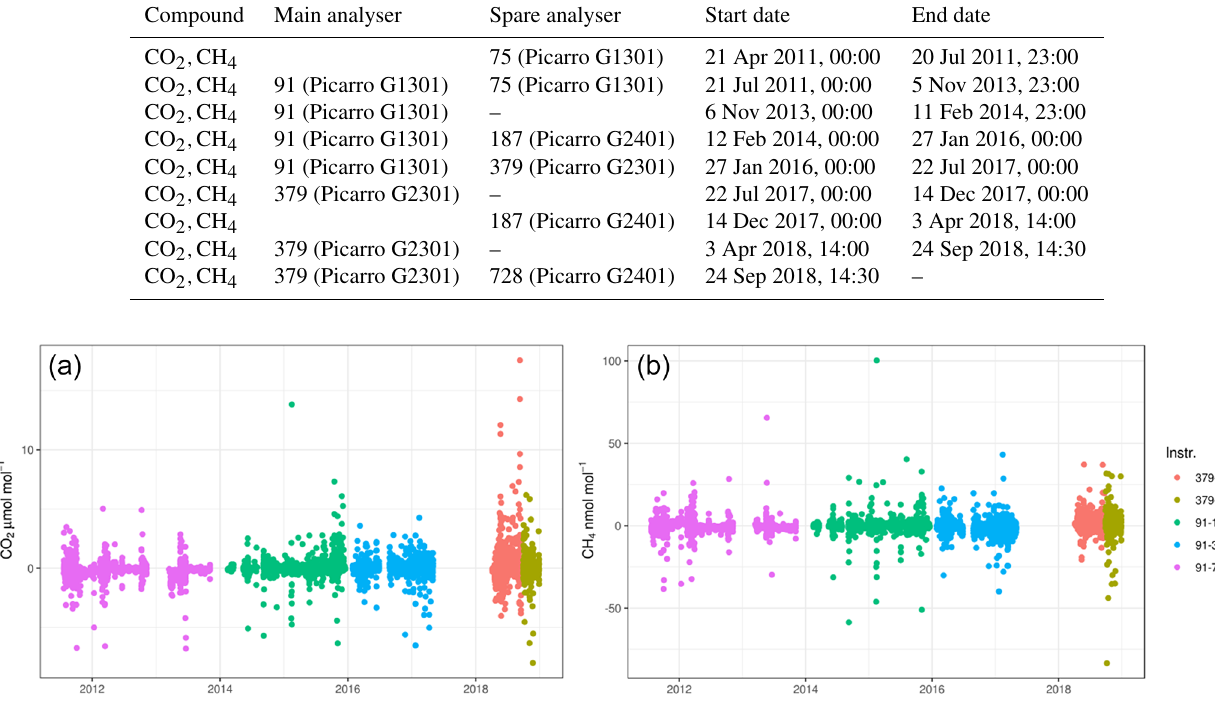
Figure 5. Difference between hourly mean afternoon (12:00–17:00UTC) data at the top level 120m from the two instruments used at the same time at the OPE station from 2011 to 2018 for CO 2 (a) and CH 4 (b) . The different instruments pairs are shown in colour and their identifiers are labelled next to (b)